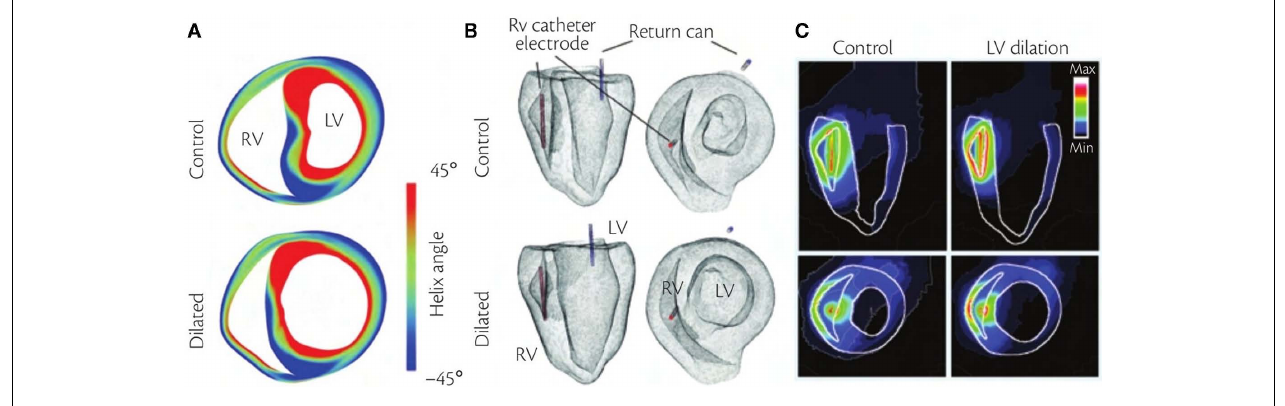
catheter (red) is in the RV cavity and the active can (blue) is in the bath near the posterior LV wall. (C) Distribution of electrical field magnitude in the normal and dilated